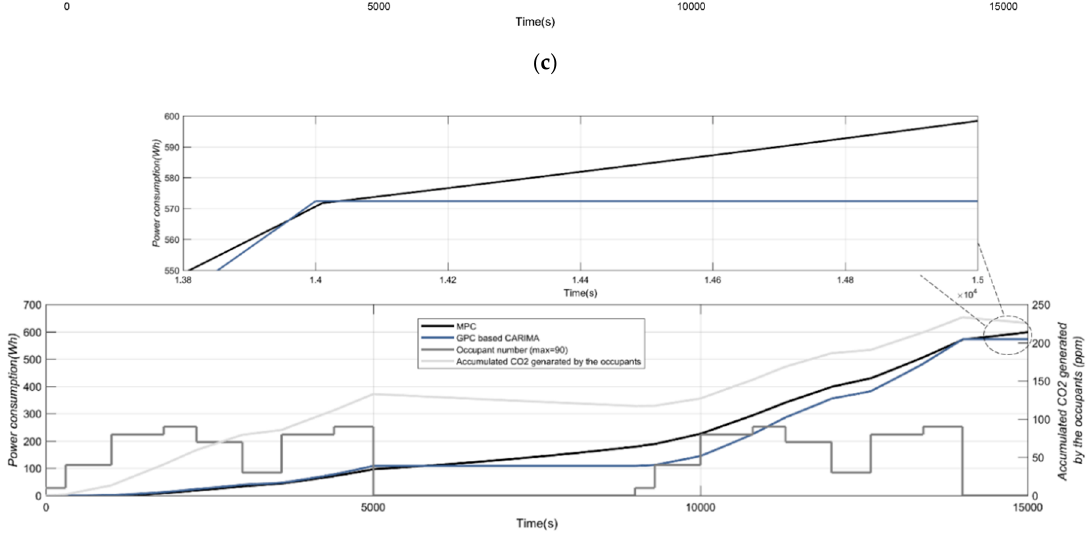
Figure 4. GPC based on CARIMA vs. the MPC: ( a ) the CO2 regulation, ( b ) the ventilation air flow rate, ( c ) the instantaneous power consumption, and ( d ) the accumulated power